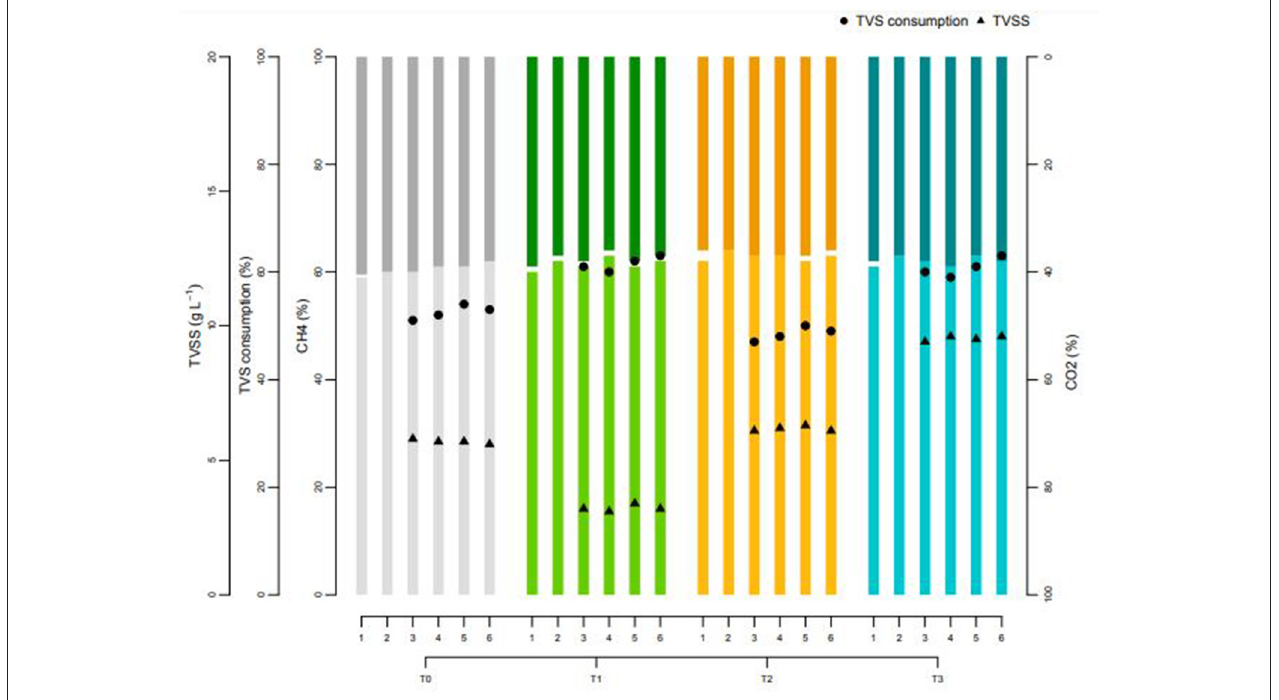
FIGURE 6 | Concentration of CH4 and CO2, evolution of organic matter consumption and suspended solids during the different trials.